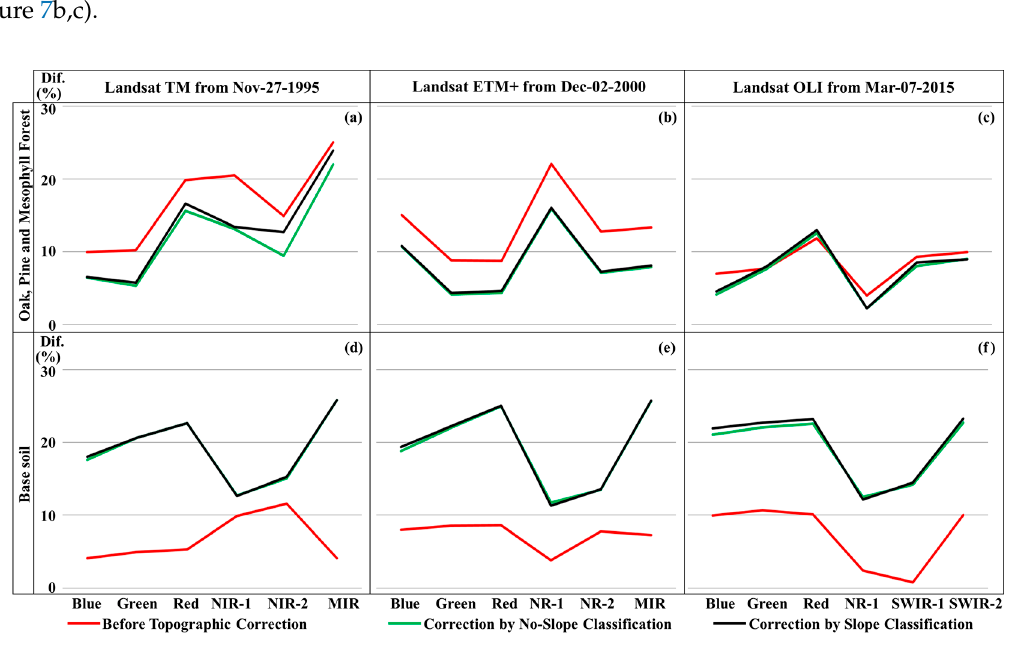
Figure 7. Relative reflectance and differences with respect to flat terrain, for oak, pine, and mesophyll forest and bare soil for the dates of study.